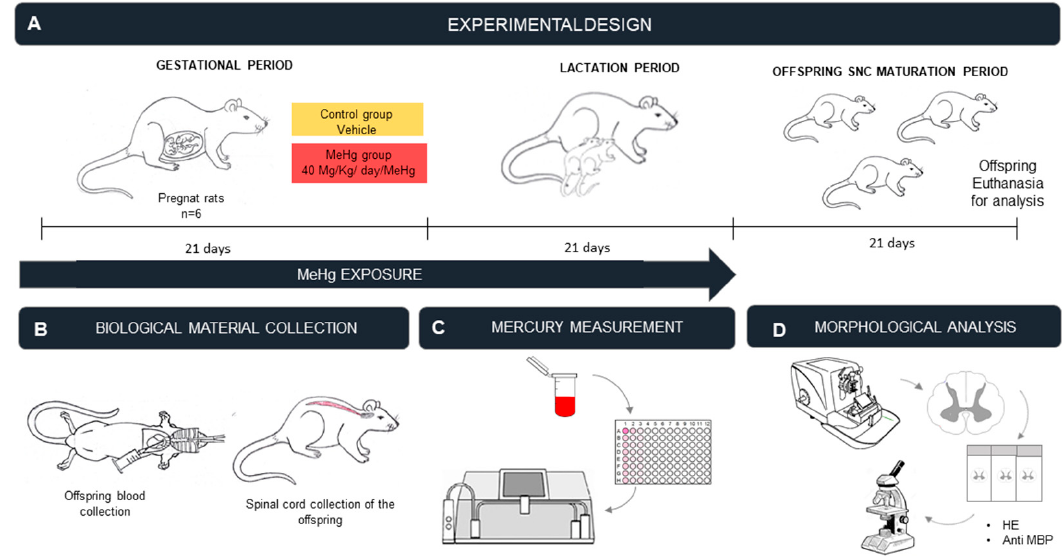
Figure 4. Methodological design: ( A ) description of the protocol for exposure of pregnant rats to MeHg; ( B ) collection of biological material from the offspring (blood and spinal cord); ( C ) quantification of mercury (Hg) in the blood; ( D ) analysis of neuronal density by counting of the motor neuron cell bodies in hematoxylin and eosin-stained sections, and evaluation of MBP immunoreactivity using immunohistochemistry.